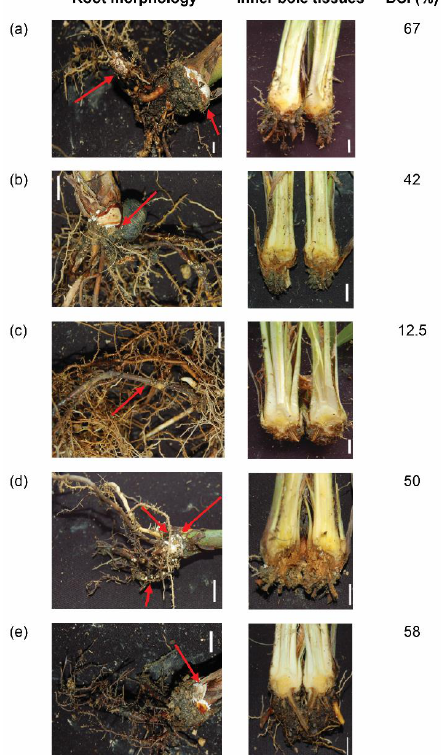
Figure 4. Root morphology and longitudinal section of bole tissues of Ganoderma -infected oil palm seedlings treated with different nitrogen sources and inoculated at 24 weeks post infection (wpi). ( a ) Without additional nitrogen source; ( b ) ammonium sulphate; ( c ) ammonium nitrate; ( d ) sodium nitrate and ( e ) potassium nitrate. Red arrow shows the formation of white mycelia or basidiocarp, and lesion sites on the roots. DSI indicates disease severity index. Scale bar represents 1 cm.